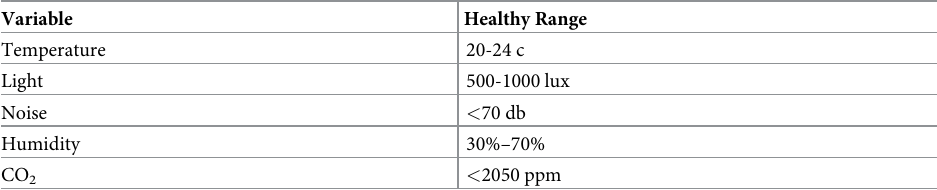
Table 3. Ranges of environmental variables considered to be healthy in this